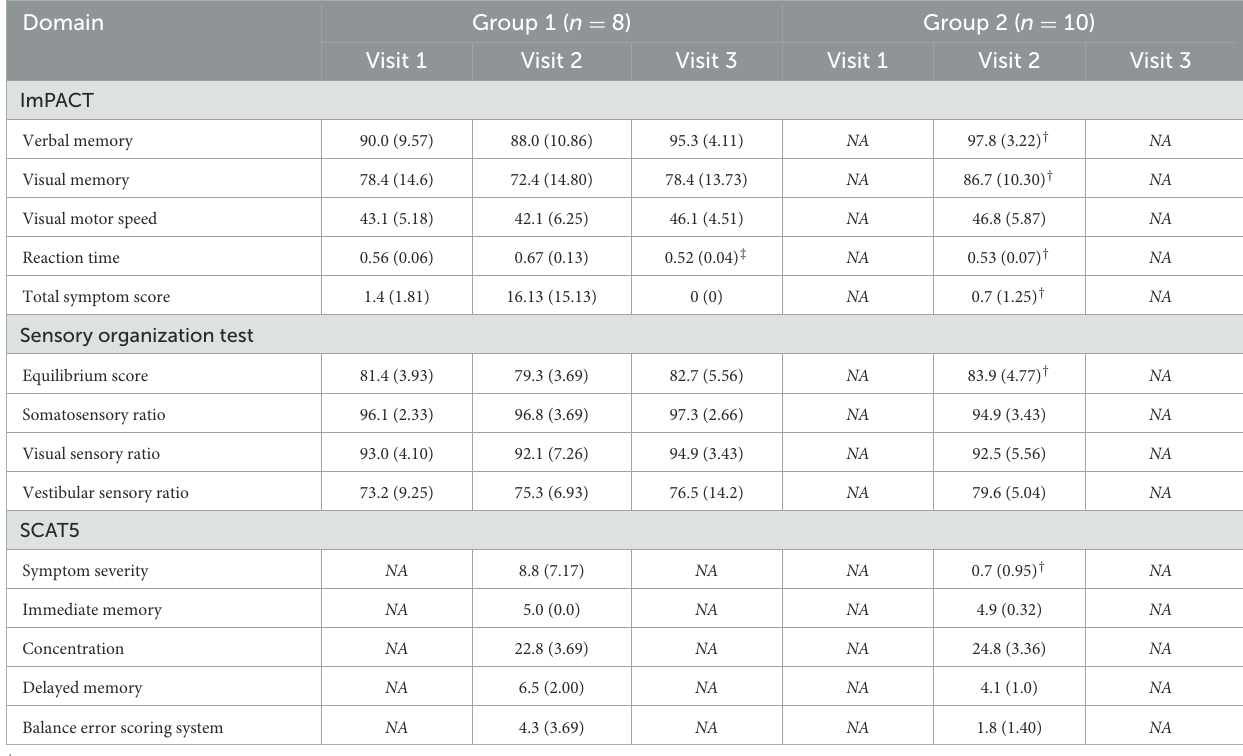
TABLE 1 A comparison of Groups 1 and 2 for the ImPACT battery and the SOT. Domain